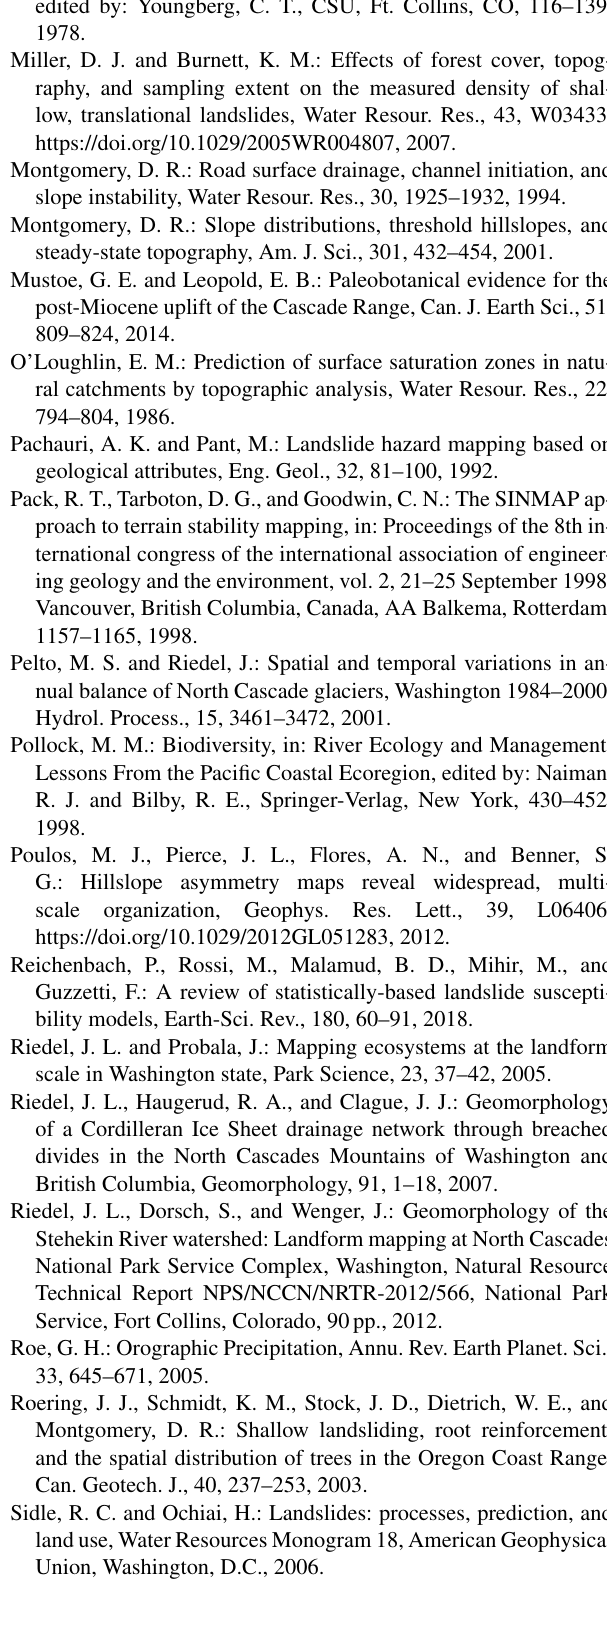
Tabor, R. W. and Haugerud, R. A.: Geology of the North Cascades: a mountain mosaic, The Mountaineers Books, Seattle, WA, 1999. Taylor, F. A. and Brabb, E. E.: Map showing landslides in Califor- nia that have caused fatalities or at least $1,000,000 in damages from 1906 to 1984, US Geological Survey Miscellaneous Field Studies Map, MF-1867, scale: 1 : 1000000, US Geological Sur- vey, Reston, Virginia, https://doi.org/10.3133/ofr86100, 1986. USGS – United States Geological Survey: National Eleva- tion Data last modified March 6, 2014, National Map Viewer, available at: https://www.nrcs.usda.gov/wps/portal/nrcs/ detail/national/?&cid=nrcs143_021626 (last access: 24 Novem- ber 2014), 2014a. USGS: National Land Cover Data (NLCD) version Marched 31, 2014, National Map Viewer, available at: https://www.usgs.gov/